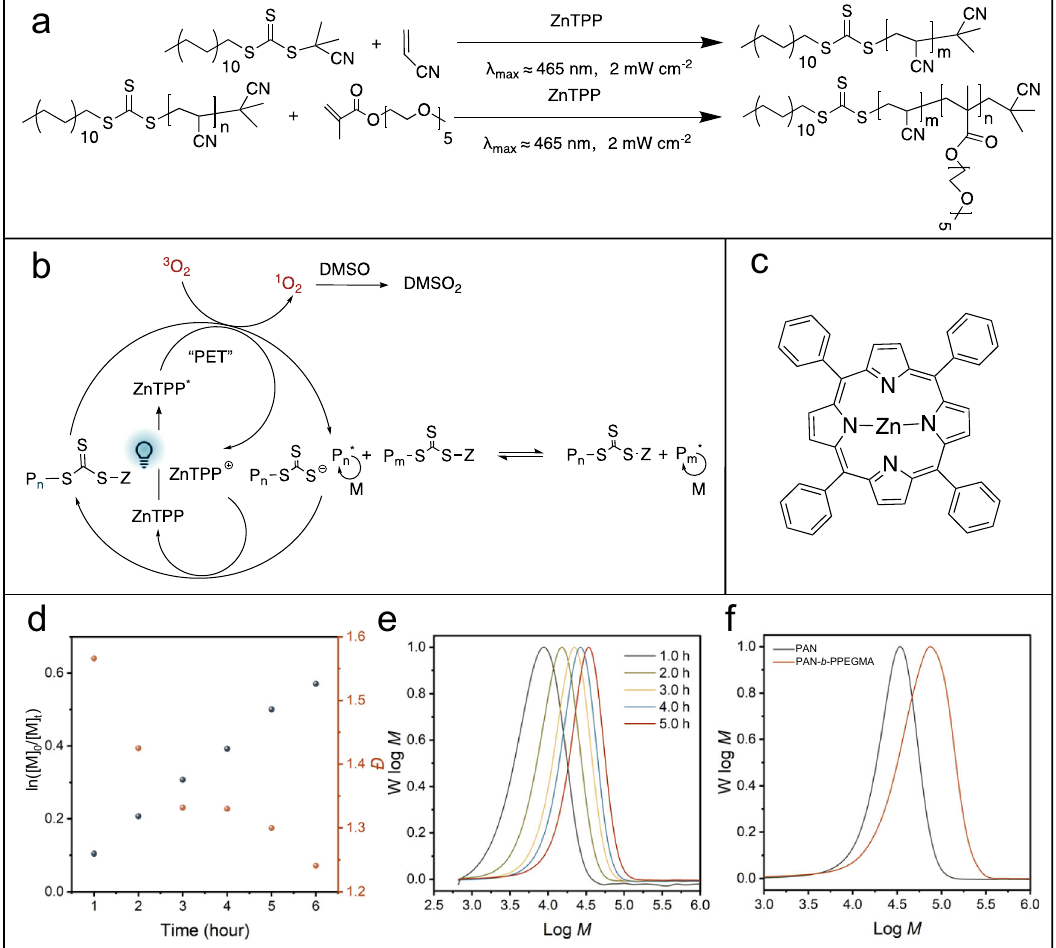
Fig. 6 Controlled synthesis of the designed polymers using the PET-RAFT polymerization. a Synthetic route of macromolecular PAN-CTA and PAN- b - PPEGMA. b Proposed mechanism of ZnTPP-catalyzed PET-RAFT polymerization. c Chemical structure of ZnTPP photocatalyst. d Kinetics of PET-RAFT polymerization of AN under blue LED irradiation (2 mW cm − 2 ) (black circles) and variation of dispersity ( Đ ) with time (red circles). e GPC pro fi les of synthesized PAN. f GPC pro fi les of PAN and PAN- b -PPEGMA by chain